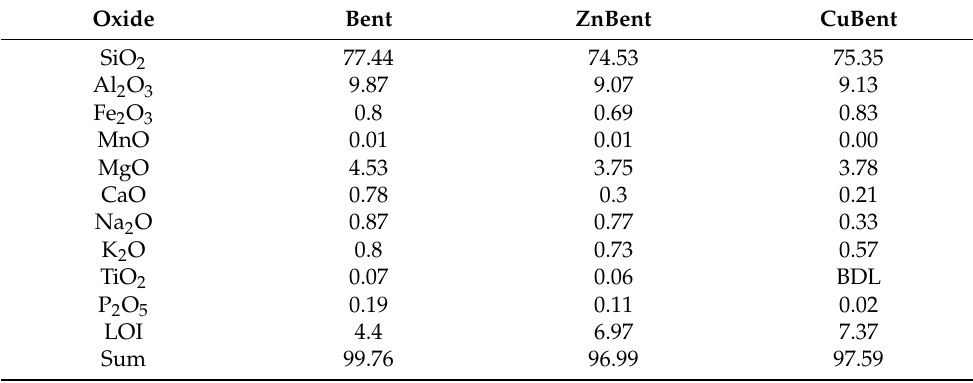
Table 1. Major element composition (% oxides) (XRF) of Bent, ZnBent, and CuBent powder